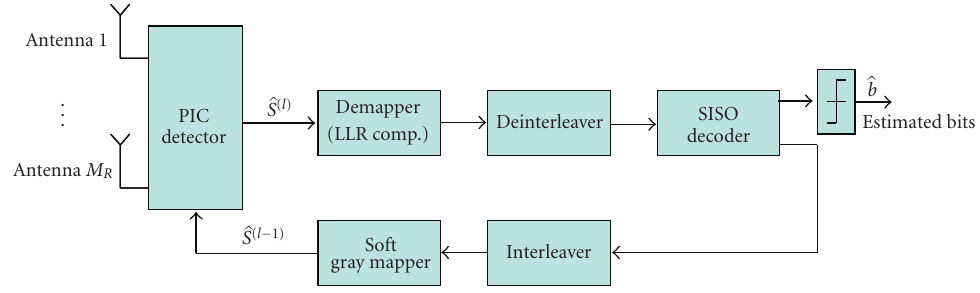
Figure 4: Iterative receiver structure.